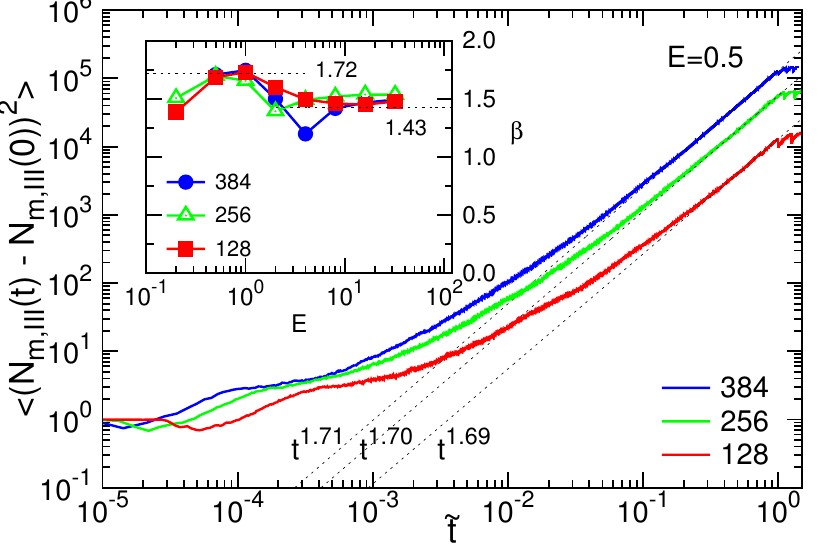
Figure 8. MSD (cid:104) ( N m,III ( t ) − N m,III ( 0 )) 2 (cid:105) at E = 0.5, plotted with the normalized time ˜ t , for N = 128, 256, and 384. (Inset) Exponent β vs. E for different N